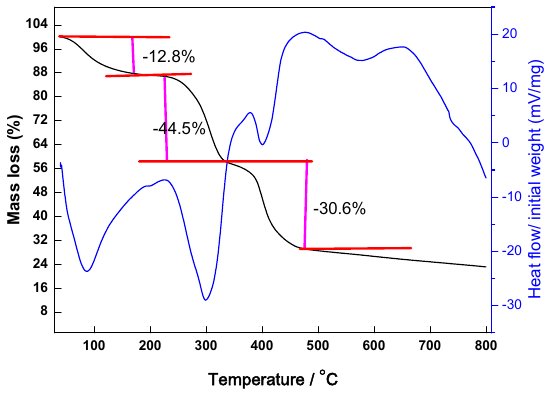
Figure 5. TGA-DSC curves of SX-1.